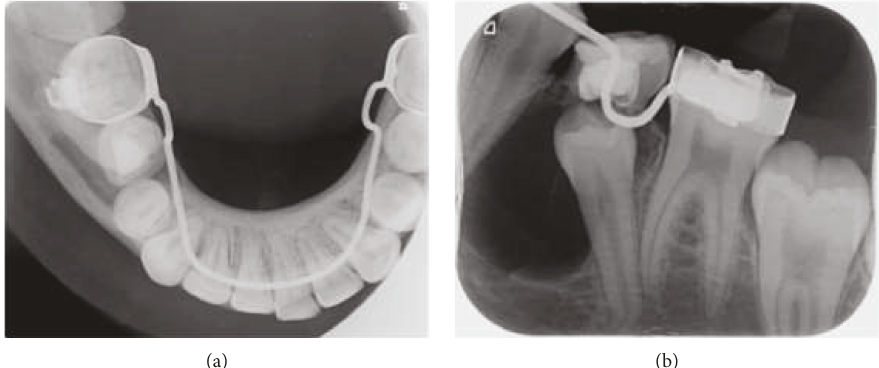
Figure 2: (a) Occlusal radiograph to further investigate the well-de fi ned radiolucent lesion. (b) Periapical radiograph to further investigate the well-de fi ned radiolucent lesion.